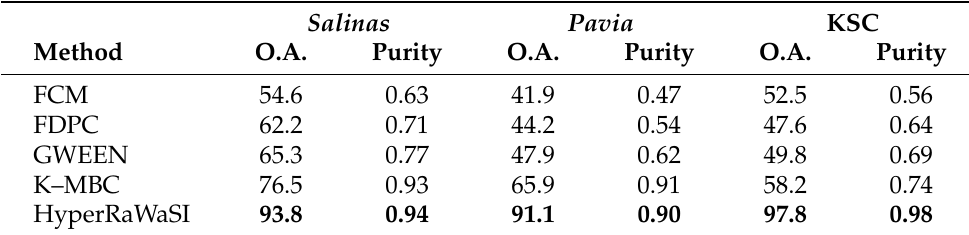
Table 2. Comparison between